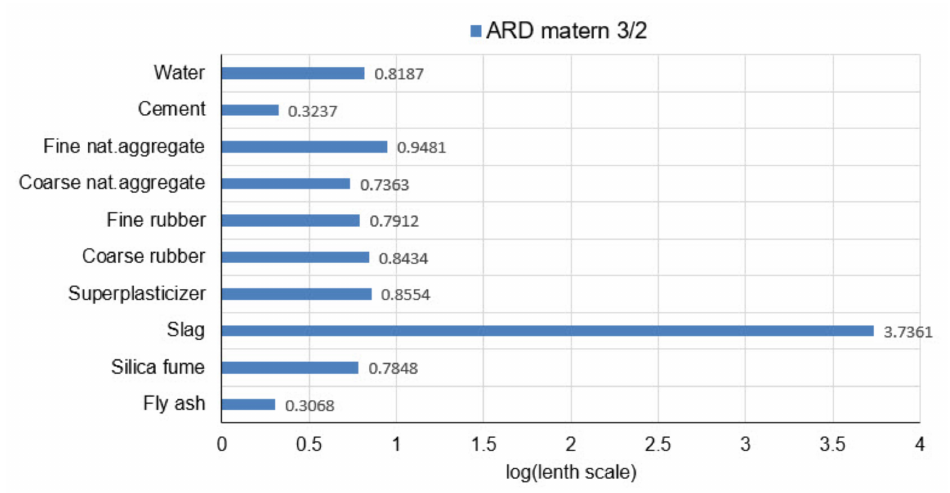
Figure 17. Variable selection using ARD Matern 3/2 covariance